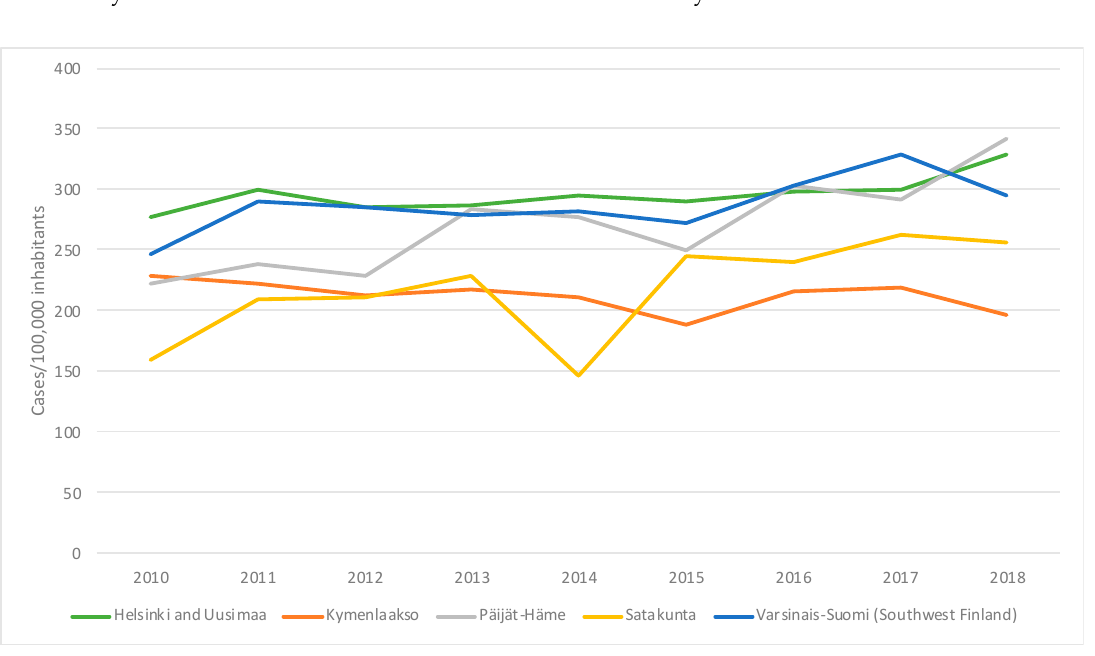
Figure 1. Incidence (cases / 100,000 inhabitants) of Chlamydia trachomatis in five Finnish hospital districts using the Aptima Combo 2 assay.